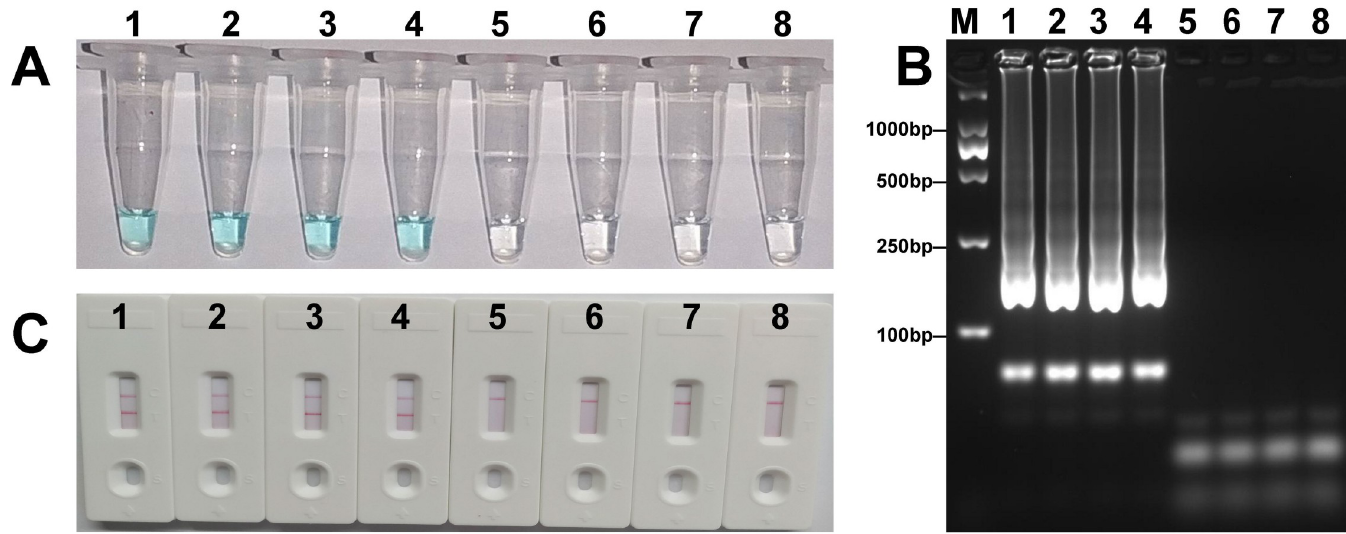
Fig 5. Sensitivity of the mcr-1- LAMP-LFB assay in spiked fecal samples. Tubes (A)/lanes (B)/biosensors (C) 1–6 represented the E . coli WHCDC128 DNA levels of 6.3 × 10 3 , 6.3 × 10 2 , 6.3 × 10 1 , 6.3, 6.3 × 10 − 1 , and 6.3 × 10 − 2 CFU per reaction, respectively. Tubes (A)/lanes (B)/biosensors (C) 7 and 8 represented the negative (non-spiked fecal sample) and blank controls (nuclease-free water),